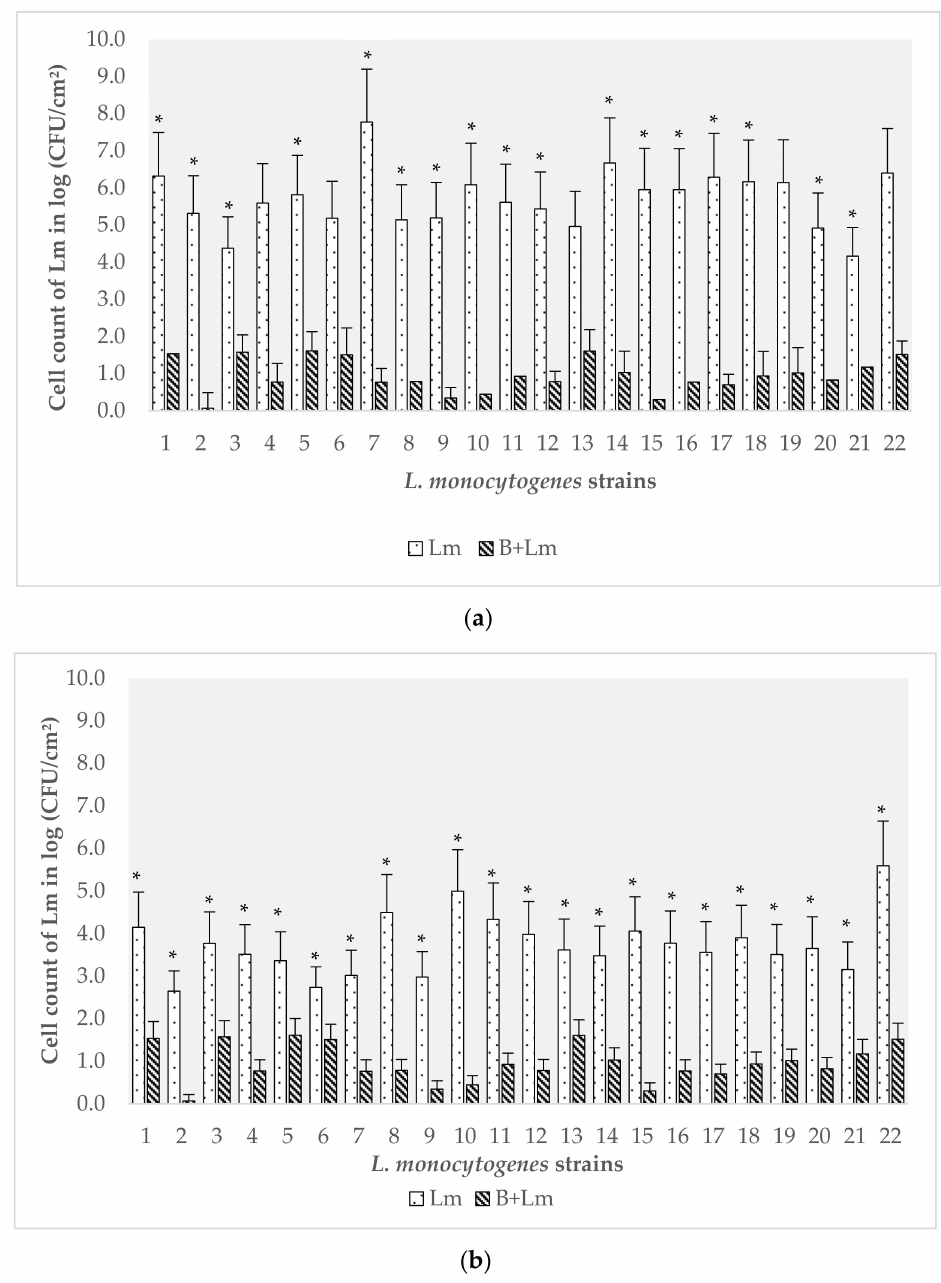
Figure 2. Counts on ALOA agar of the 22 Listeria monocytogenes strains as controls (Lm), and the respective counts in the mixed biofilms with B. safensis (B + Lm) at two days ( a ) and seven days ( b ) of incubation. The error bars represent the standard error of the mean (n = 6). * indicates significant differences ( p < 0.05) between the experimental group (B + Lm) and its respective control